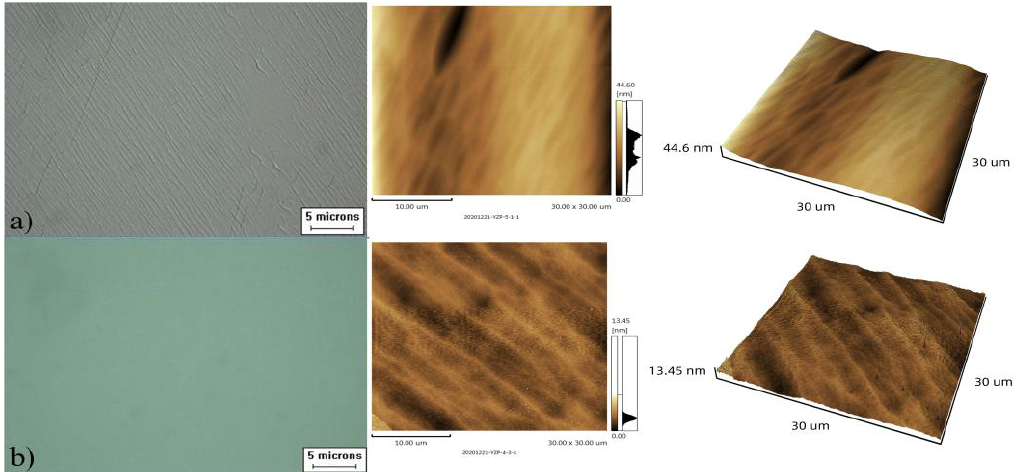
Figure 6. The morphology of each group after etching: ( a ) the 6th group; ( b ) the 7th group.